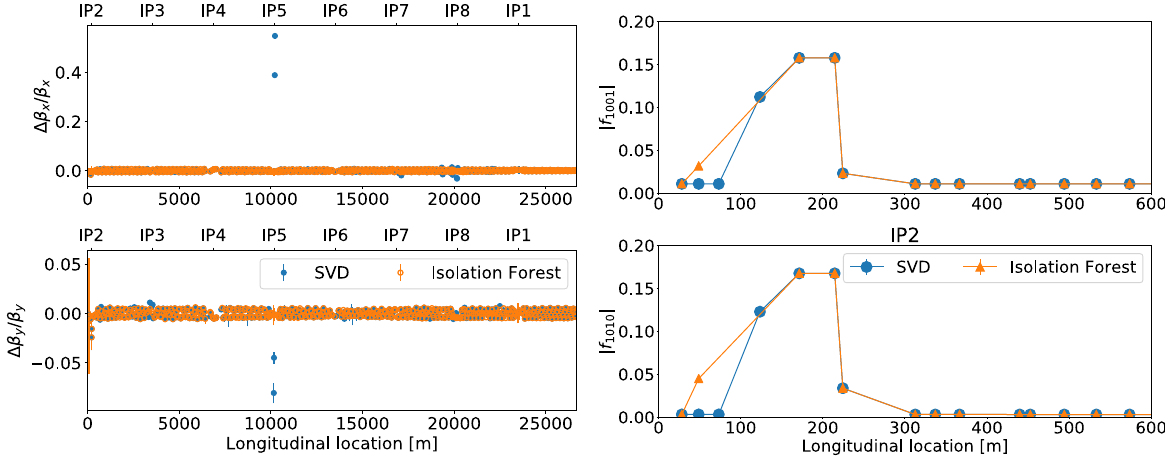
FIG. 13. Application of IF on SVD cleaned data reduced the number of outliers in beta beating (left) so the simulated bad BPMs are detected correctly. At the same time the introduced coupling bump in IP2 is still present (right), showing that the signal at the location of the coupling bump (BPMSW.1R2.B1, BPMSW.1L2.B1) where f 1001 and f 1010 reach their maximum values is not classified as anomaly as